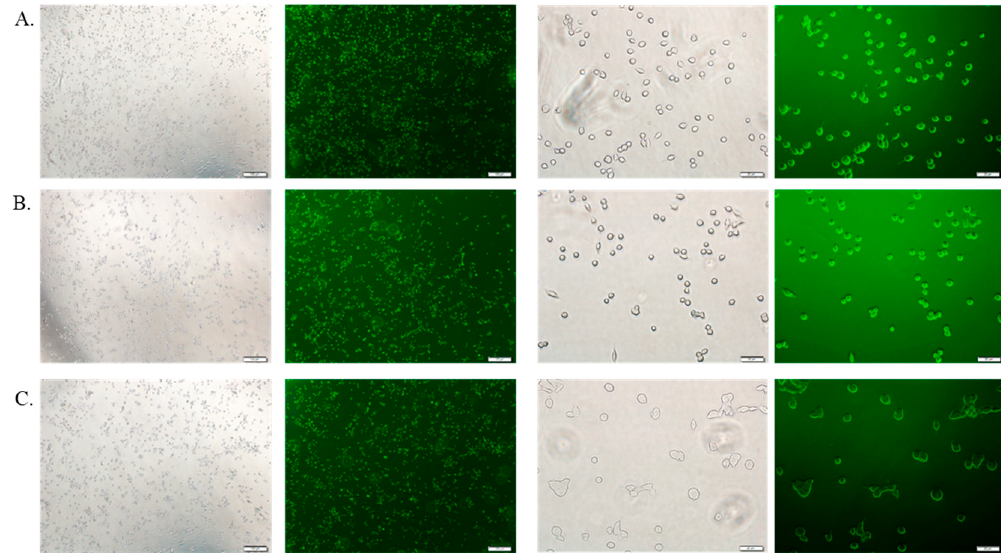
Figure 12. Fluorescence image analysis of MCF-7 cells incubated with DOX 5 µM ( A ) , DOX-loaded CA NPs (5 µM); ( B ) and DOX-loaded CMCA NPs (5 µM); ( C ) at 37 °C for 4 h with 4× and 20× magnifications at a scale bar of 100 µm and 20 µm.